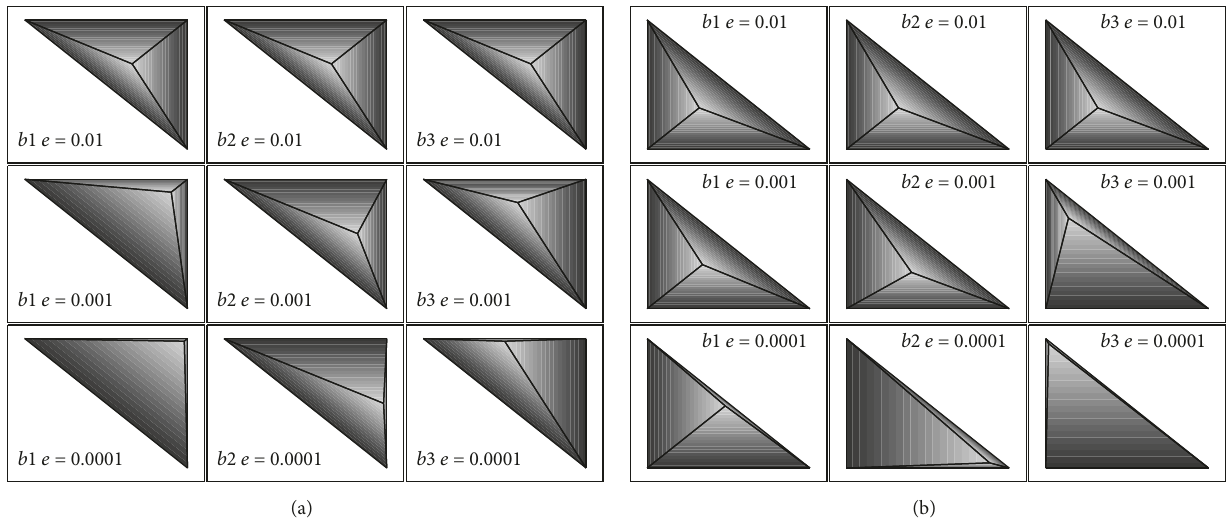
Figure 3: Bubble functions, 𝑏 1 , 𝑏 2 , 𝑏 3 , in a typical element having (a) one inflow edge and (b) two inflow edges, when 𝛽 = ( sin 72 ∘ , cos 72 ∘ ) , 𝜎 = 0.001 , 𝜖 = 10 −2 ,10 −3 ,10 −4 , and 𝑁 = 10 (figure reproduced from [15] [under the Creative Commons Attribution License/public domain]).